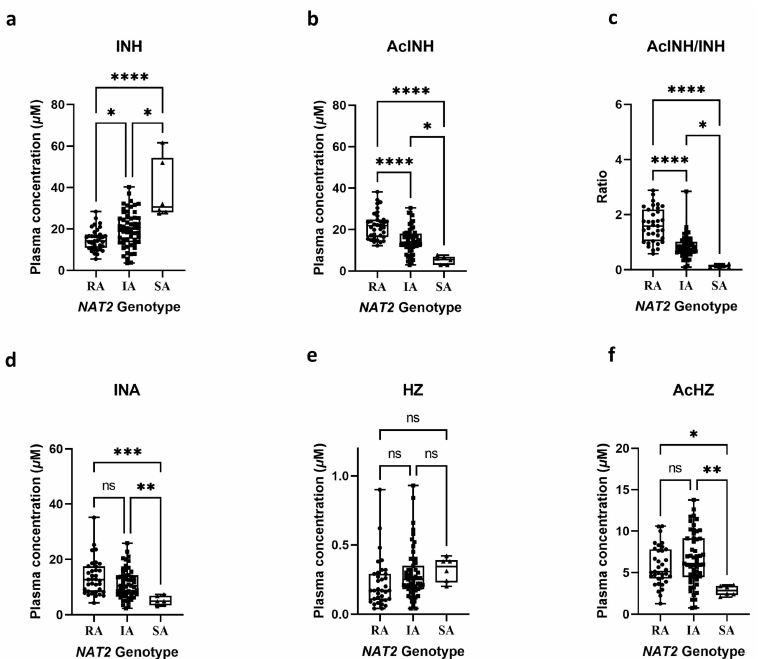
Figure 3. Concentrations, ratio of isoniazid and four metabolites in tuberculosis (TB) patients’ plasma at 2 h after drug administration according to N-acetyltransferase-2 ( NAT2 ) phenotypes: ( a ) isoniazid 2 h postdose plasma concentration in TB patients according to NAT2 phenotypes; ( b ) acetylisoniazid 2 h postdose plasma concentration in TB patients according to NAT2 phenotypes; ( c ) acetylisoniazid/isoniazid 2 h postdose plasma ratio in TB patients according to NAT2 phenotypes; ( d ) isonicotinic acid 2 h postdose plasma concentration in TB patients according to NAT2 phenotypes; ( e ) hydrazine 2 h postdose plasma concentration in TB patients according to NAT2 phenotypes; ( f ) acetylhydrazine 2 h postdose plasma concentration in TB patients according to NAT2